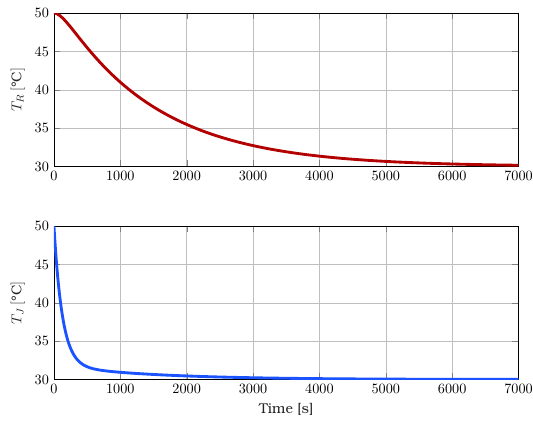
Figure 7. The evolutions of the jacket ( T J ) and the reactor temperature ( T R ) in the case of the non-isothermal batch system.